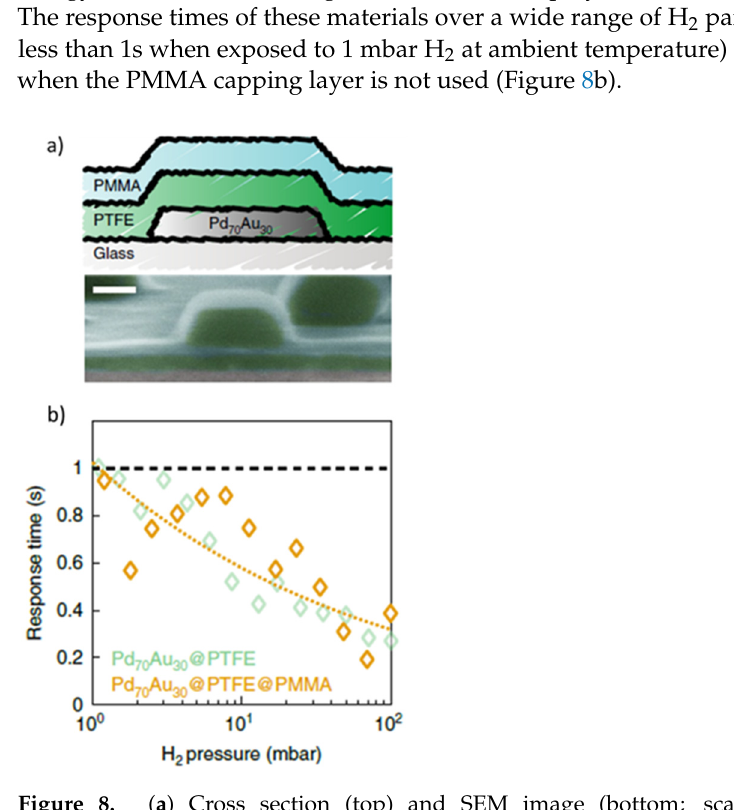
Figure 8. ( a ) Cross section (top) and SEM image (bottom; scale bar of 100 nm) of a Pd 70 Au 30 @PTFE@PMMA nanodisc-based tandem sensor. ( b ) Response time as a function of H 2 pressure when the material was coated only with PTFE or with PTFE and PMMA. The dashed orange line represents a power-law fit through the data corresponding to the Pd70Au30@PTFE@PMMA. Reproduced from [33], with permission from Nature Publishing Group, 2019.